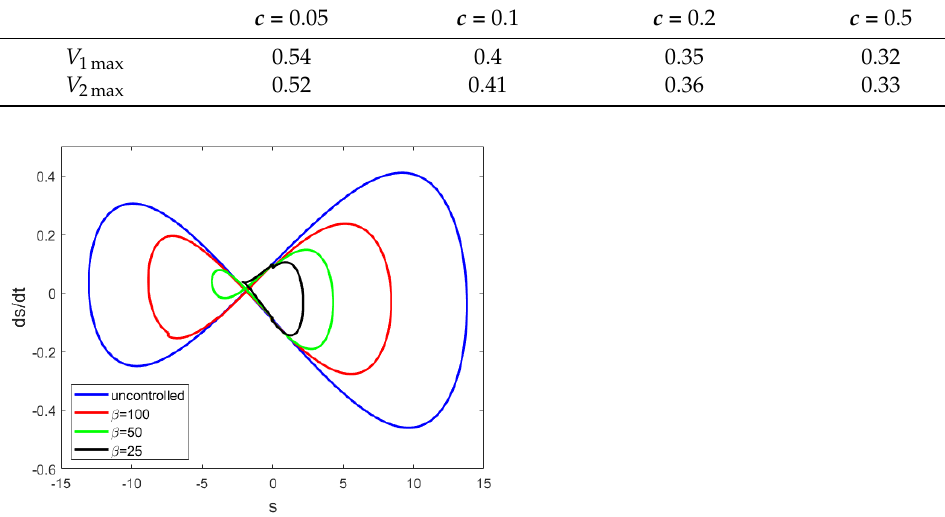
 . for various amounts of β and considering s for various amounts of β and considering p = 19, . V and V 1 2